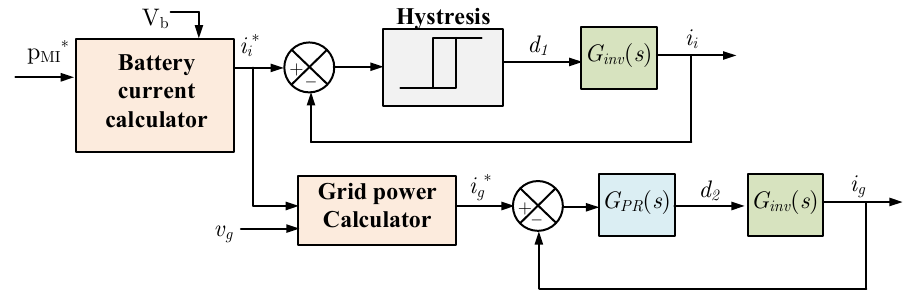
Figure 11. MCI controller during DC/AC inversion from battery packs to grid.